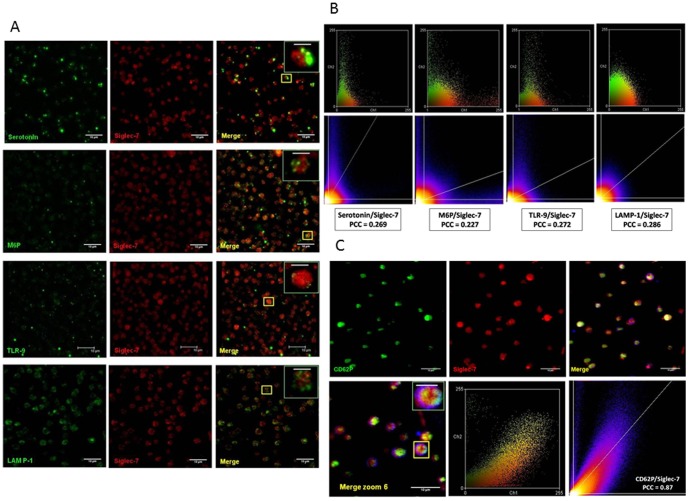
Siglec-7 localization in human platelets.(A) Siglec-7 does not colocalize with markers for dense granules, lysosomes, T-granules or endosomes. From top to bottom: intra-platelet Siglec-7 was co-stained with serotonin (dense granules), M6P (endosomes), TLR-9 (T-granules), and LAMP-1 (lysosomes) using two distinct colored secondary antibodies. Insets represent magnified regions shown in yellow boxes. Scale bars = 10 µm, except insets where scale bars = 2 µm. (B) Scattergram, scatter plot, and colocalization analysis of Serotonin/Siglec-7; M6P/Siglec-7; TLR-9/Siglec-7; and LAMP-1/Siglec-7 (left to right). Siglec-7 did not colocalize with any proteins (Pearson correlation analysis, p>0.05). (C) Siglec-7 colocalized with CD62P, an α-granule marker. Scale bars = 10 µm except insets bars, which = 2 µm. Pearson correlation analysis, p<0.05.